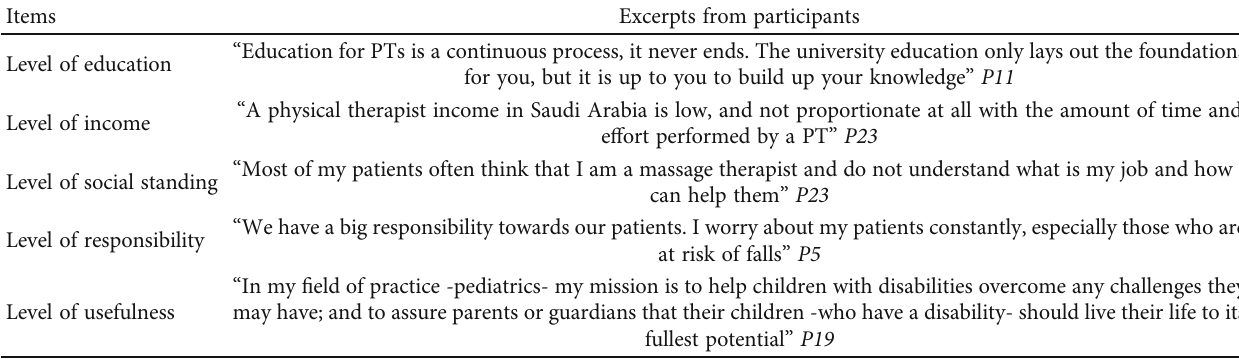
Table 3: Excerpts taken from participants ’ semi-structured